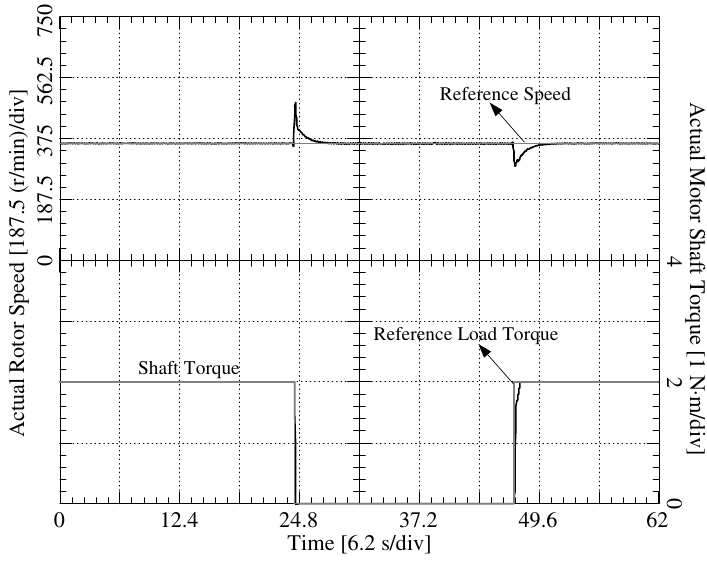
Figure 8. Experimental speed response when full load (2 N·m) rejection and injection are applied respectively under 360 r/min steady-state speed with K = 1 (low).